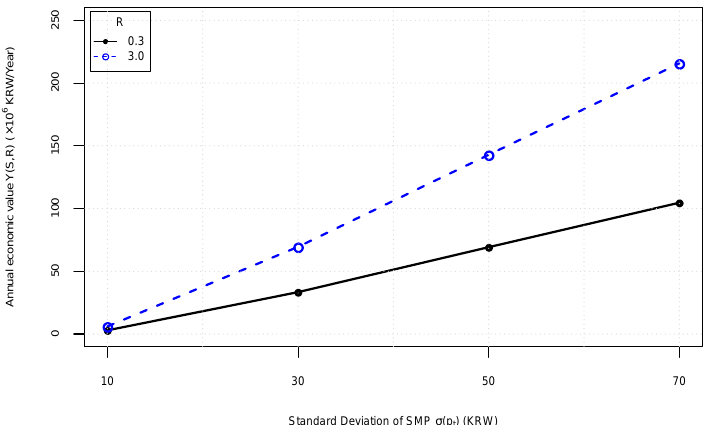
Figure 13. Annual economic values Y ( S , R ) for different standard deviations of SMP σ ( p t ) ( m , h ) ( ¯ p = 150 t